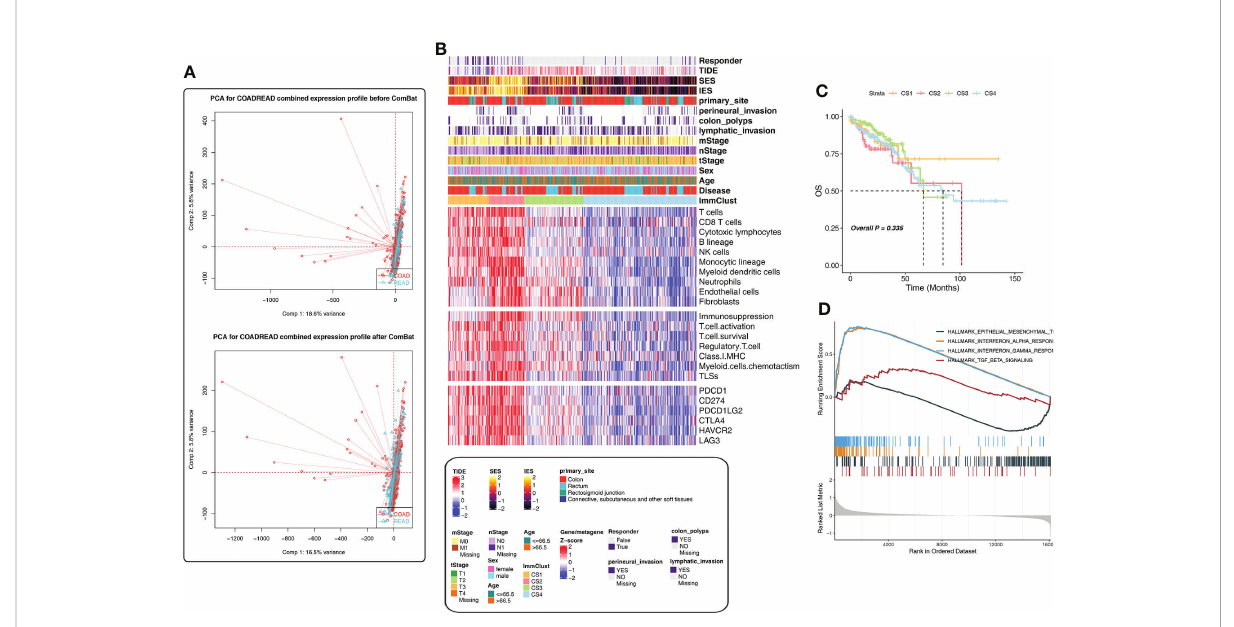
FIGURE 1 Immune-related cluster establishment for The Cancer Genome Atlas (TCGA). (A) Batch effect removal of the TCGA-COAD and TCGA-READ cohorts using PCA analysis. (B) The heatmap showed the differences in the distribution of the four ImmClusts in clinicopathological features, TME compositions, functional orientation, immune checkpoints, and so on. (C) K ‐ M survival curves showed the differences of overall survival and recurrence rate among the four ImmClusts. (D) GSEA analysis comparing the differences of enrichment pathways between CS1 and the other